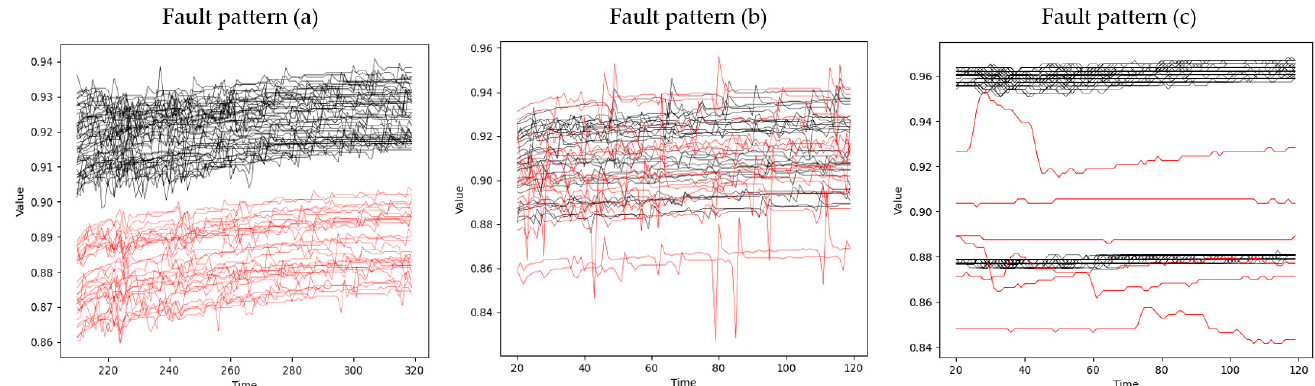
Figure 1. Three representative fault patterns.